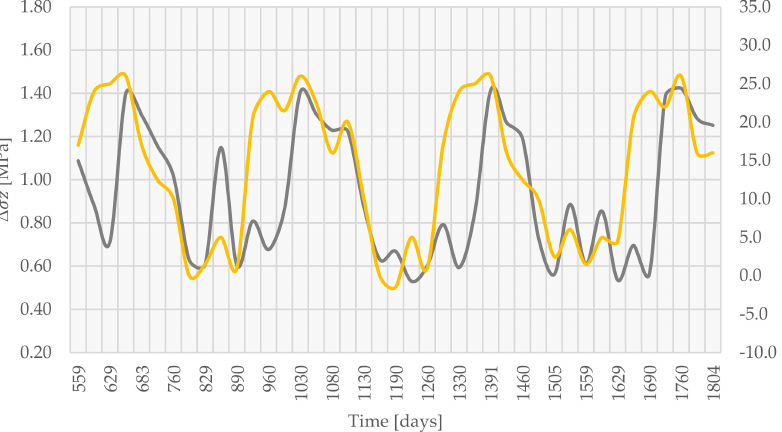
Figure 25. The difference between extreme values of σ z [MPa] between two monolith lengths as a function of the time period after the completion of construction (grey) and ambient temperature T a [ ◦ C ] (yellow).